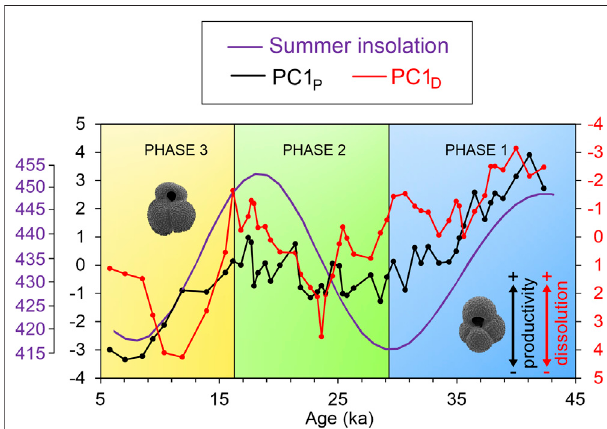
FIGURE 3 | Mean average for the fi rst principal components of principal component analyses on all productivity proxies (PC1 P , black line) and all dissolution proxies (PC1 D , red line) in samples from sediment core SAT-048A in the South Atlantic. The purple line represents the Austral summer (February)insolationat31 ° S(Laskaretal.,2004).Thethreephasesde fi nedby productivity trends (decreasing in phases 1 and 3, increasing in phase 2) are indicated. Dominant species of planktonic Foraminifera ( Globigerina bulloides in phase 1, Globigerinoides ruber in phase 3) are indicated.